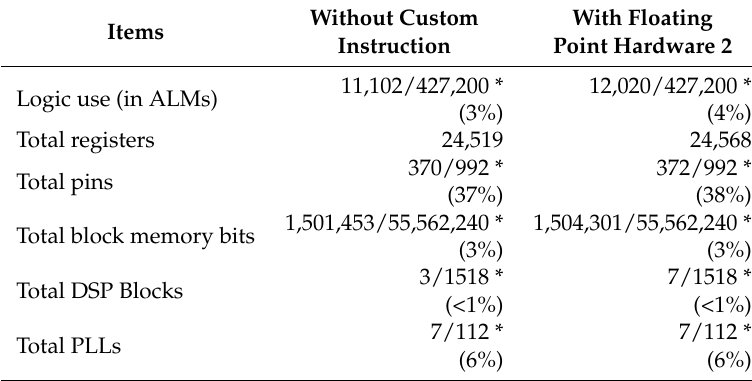
Table 5. SHA-3 Algorithm with the Keccak hash function synthesis